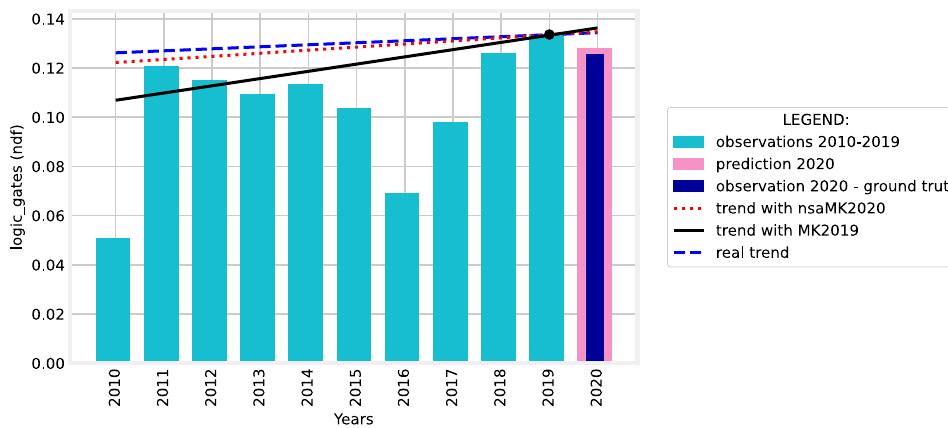
Figure 2. Trend evaluation comparison for the key term ’logic